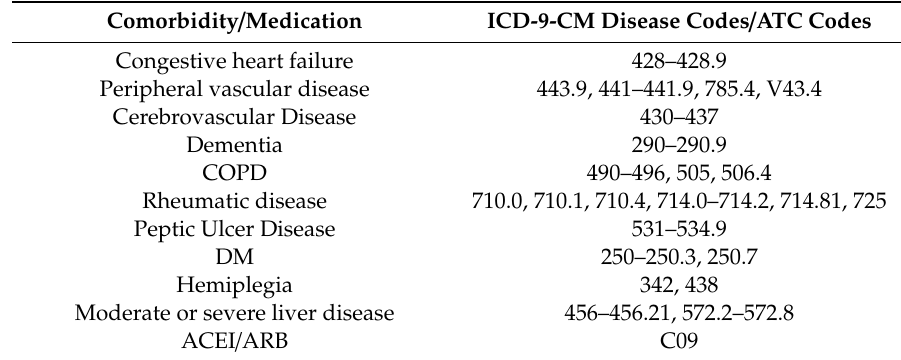
Table 1. Disease diagnosis codes according to the international classification of diseases, ninth revision, clinical modification (ICD-9-CM), and prescribed medications are classified based on anatomical therapeutic chemical (ATC)